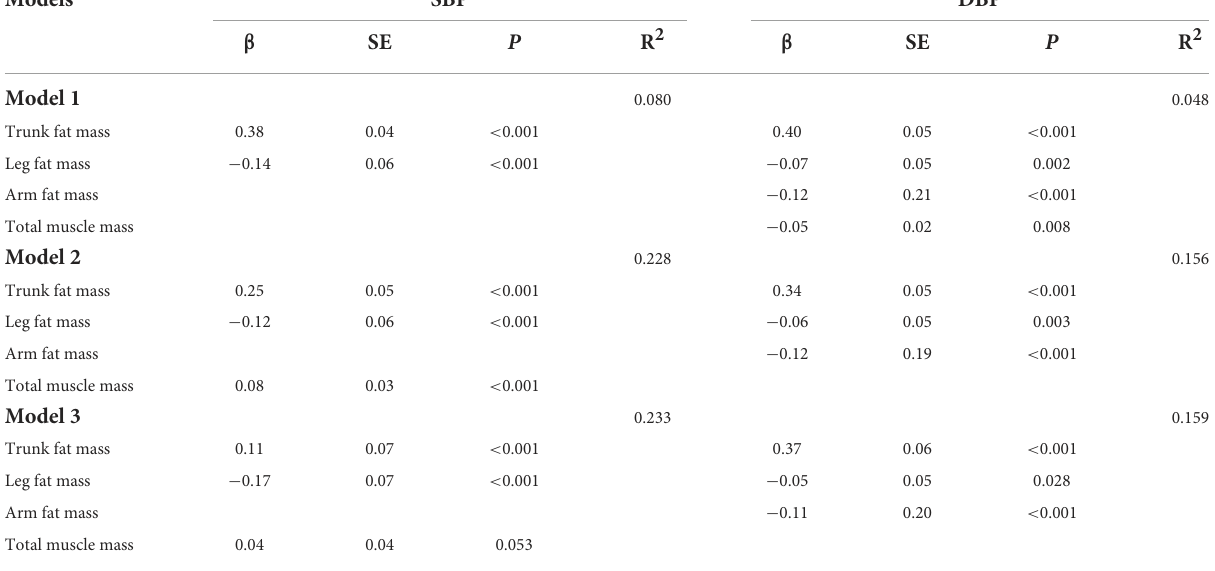
TABLE 3 Impact of different components of body composition on BP in women.